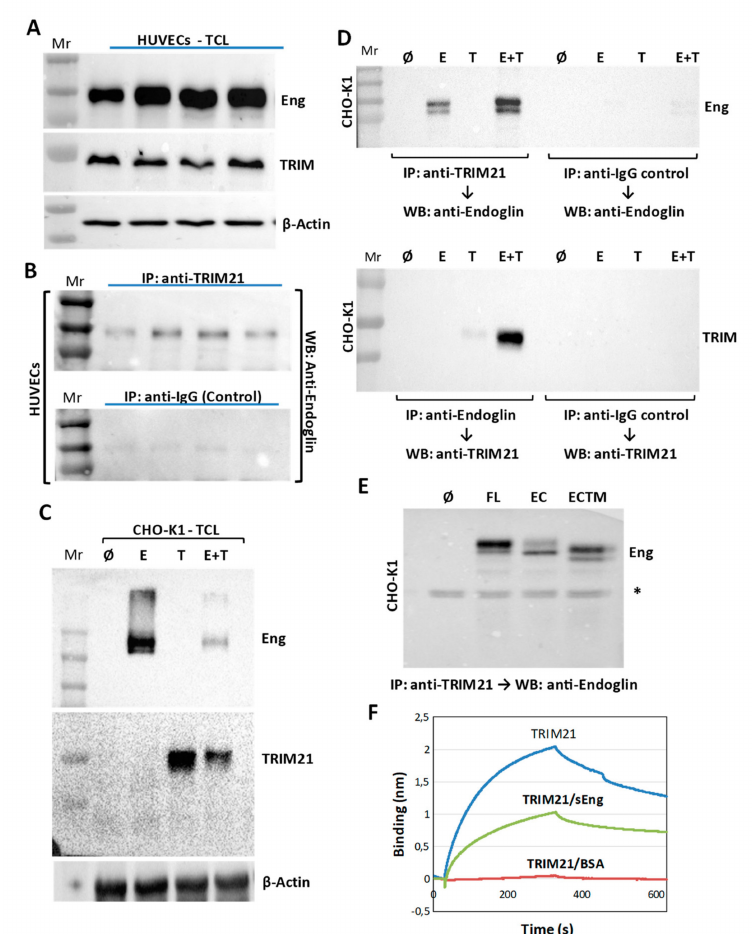
Figure 3. Protein–protein association between TRIM21 and endoglin. ( A – E ) Co-immunoprecipitation of TRIM21 and endoglin. A,B. HUVEC monolayers were lysed and total cell lysates (TCL) were subjected to SDS-PAGE under reducing (for TRIM21 detection) or nonreducing (for endoglin detection) conditions, followed by Western blot (WB) analysis using antibodies to endoglin, TRIM21 or β -actin ( A ). HUVECs lysates were subjected to immunoprecipitation (IP) with anti-TRIM21 or negative control antibodies, followed by WB analysis with anti-endoglin ( B ). C,D.